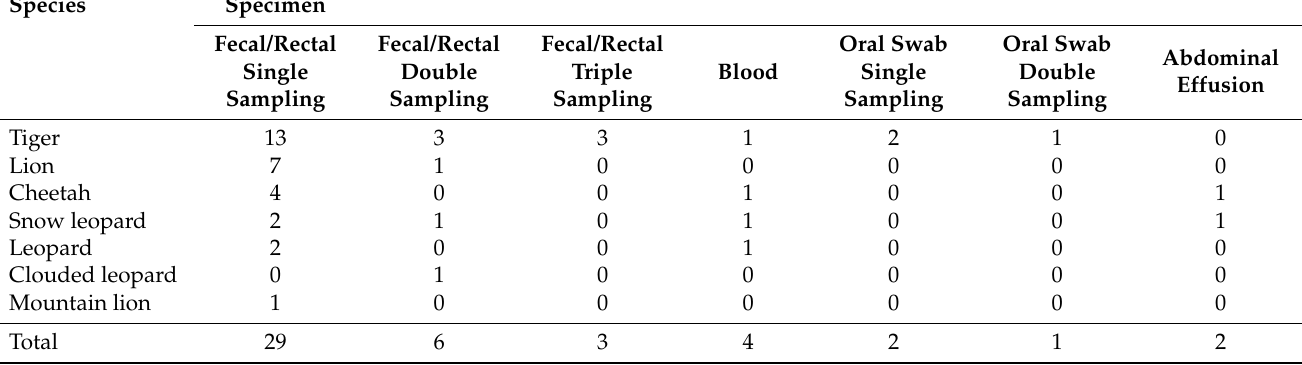
Table 2. Number and type of specimens analyzed in this study.